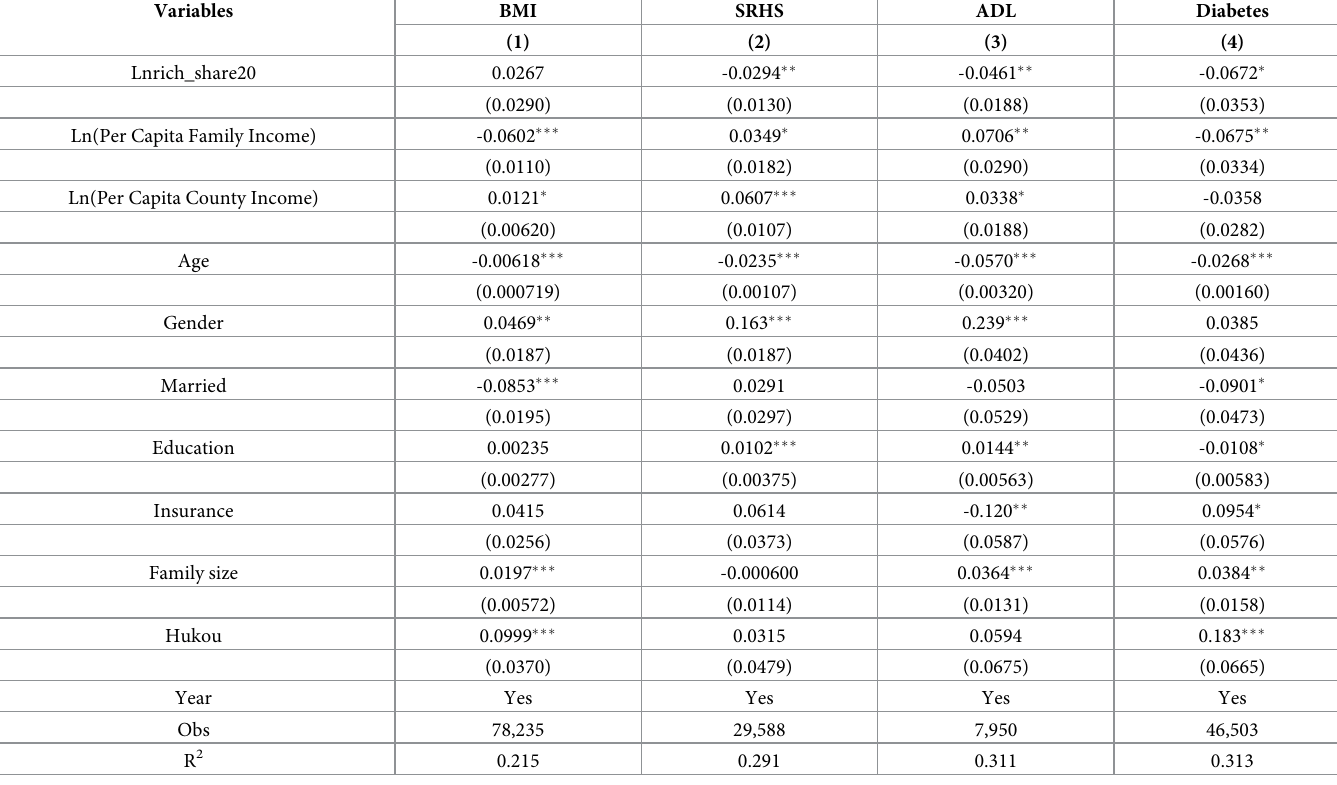
Table 4. The effects of rich share (20%) on individual